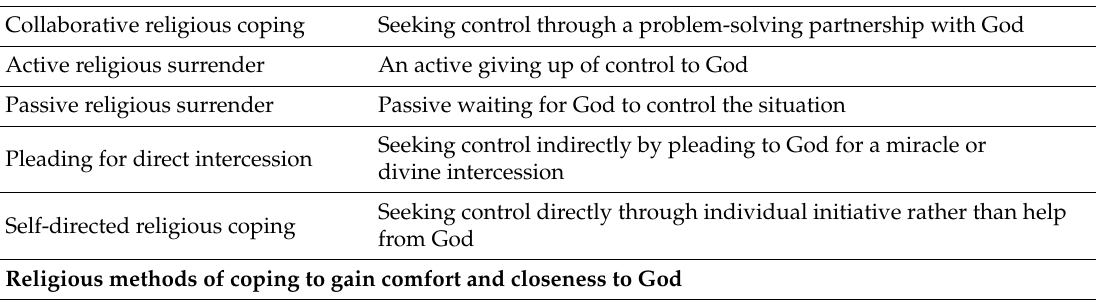
Table A1. Pargament et al. (2011) Religious Coping Subscales and definitions of religious coping methods